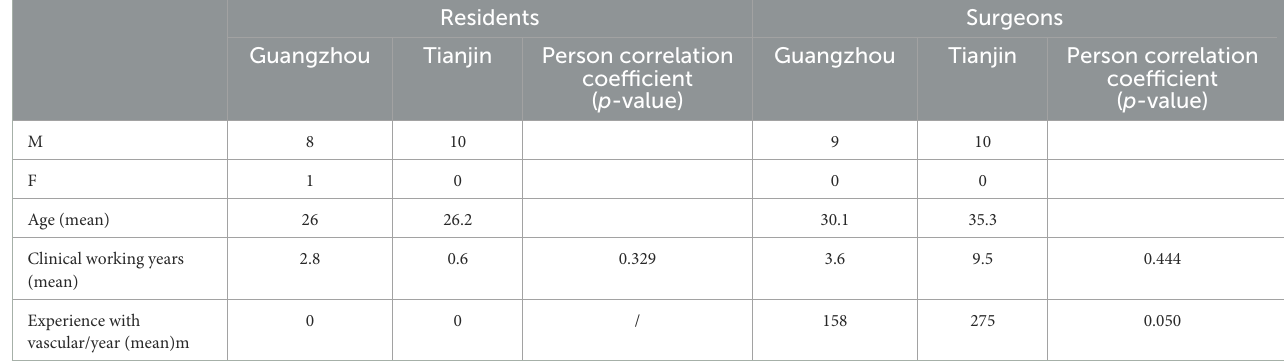
TABLE 1 Background information of participants.